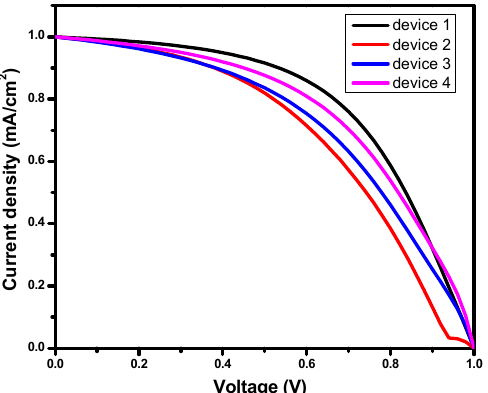
Figure 8. Current density versus voltage plot for 200 nm thickness of absorber layer in the devices 1, 2, 3 and 4.